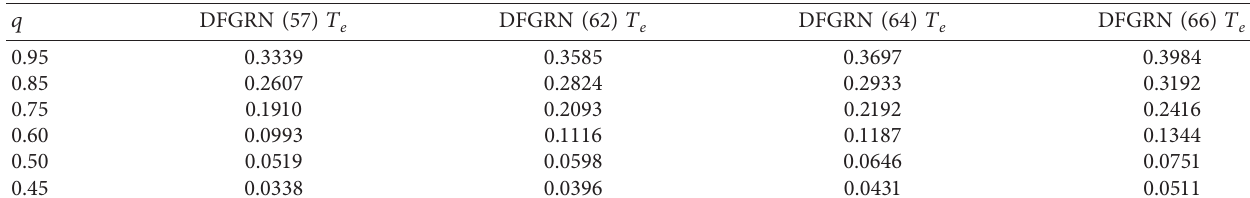
e of finite-time stability with different fractional-order